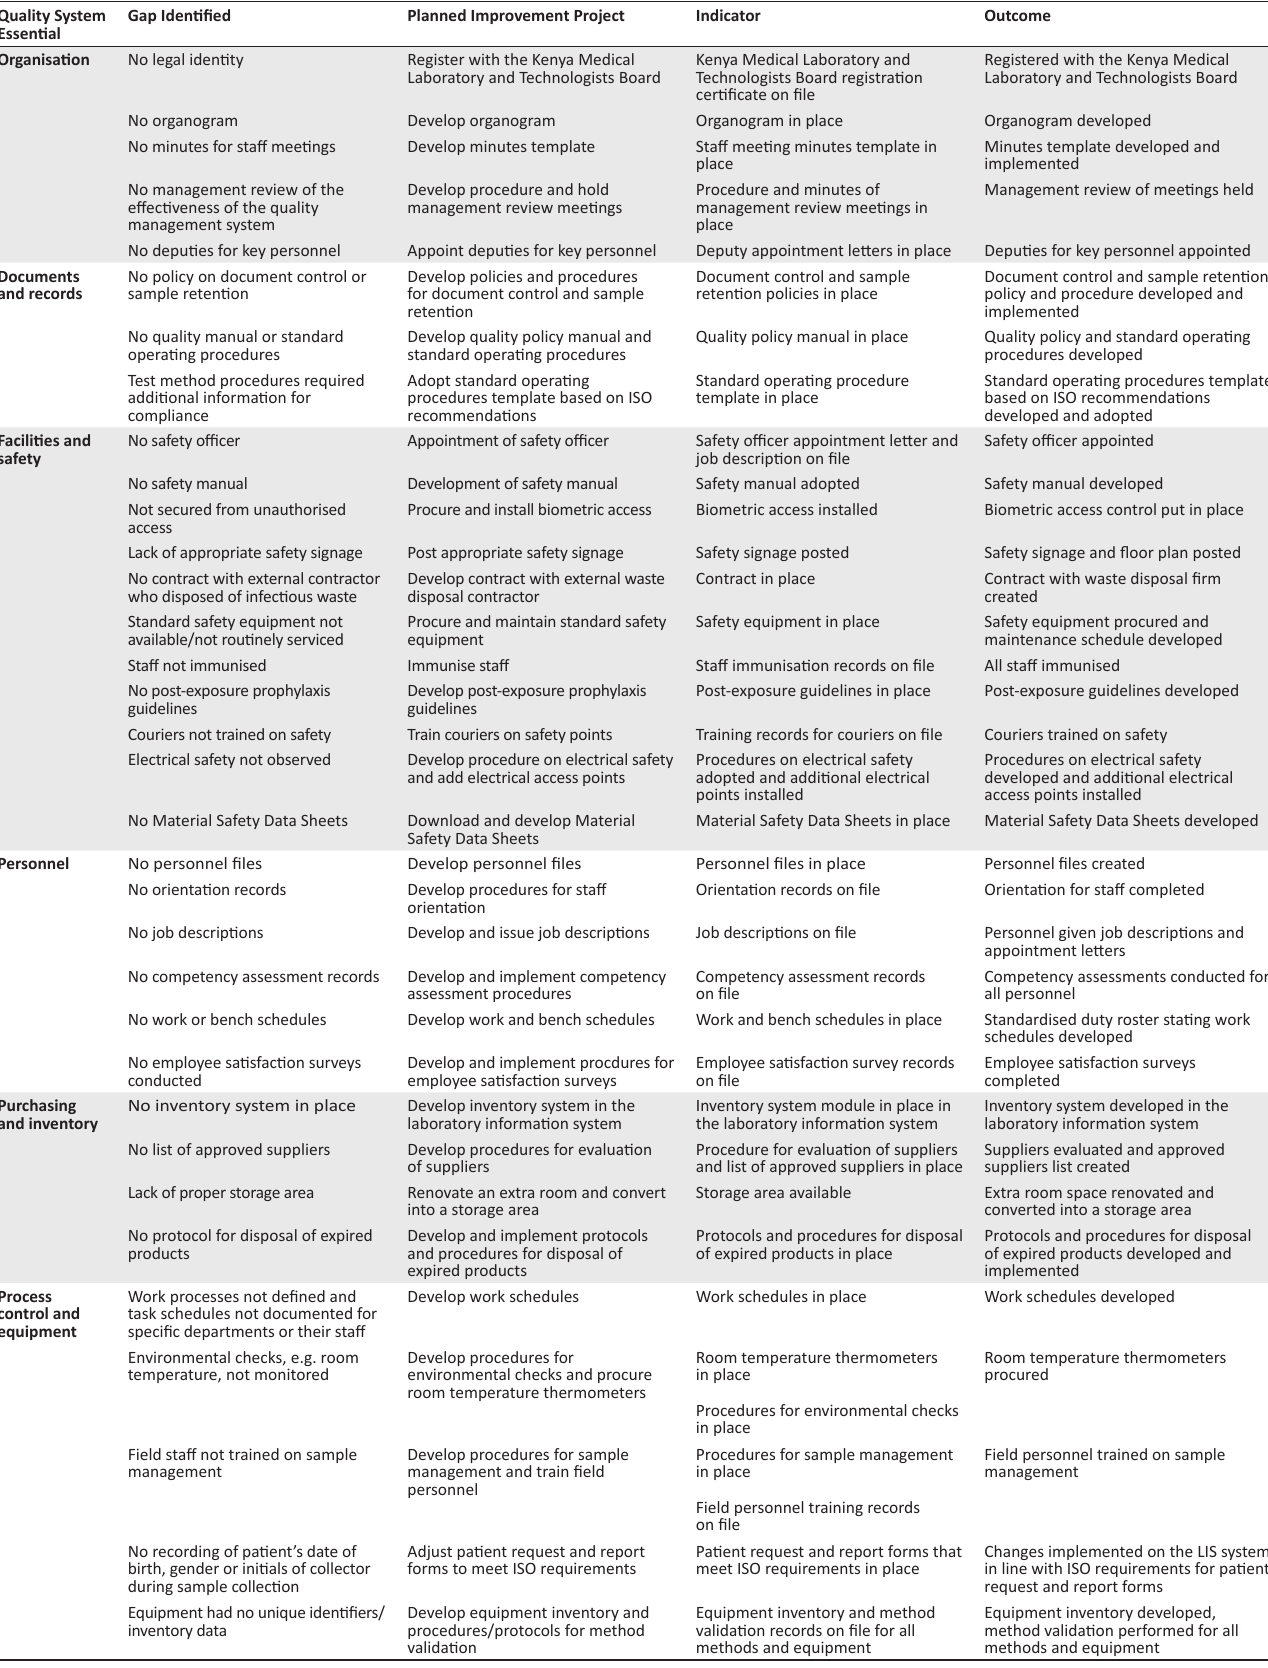
TABLE 1: Gaps identified and corresponding improvement projects conducted for SLMTA implementation at Kenya’s National HIV Reference Laboratory, 2010–2013. Quality System